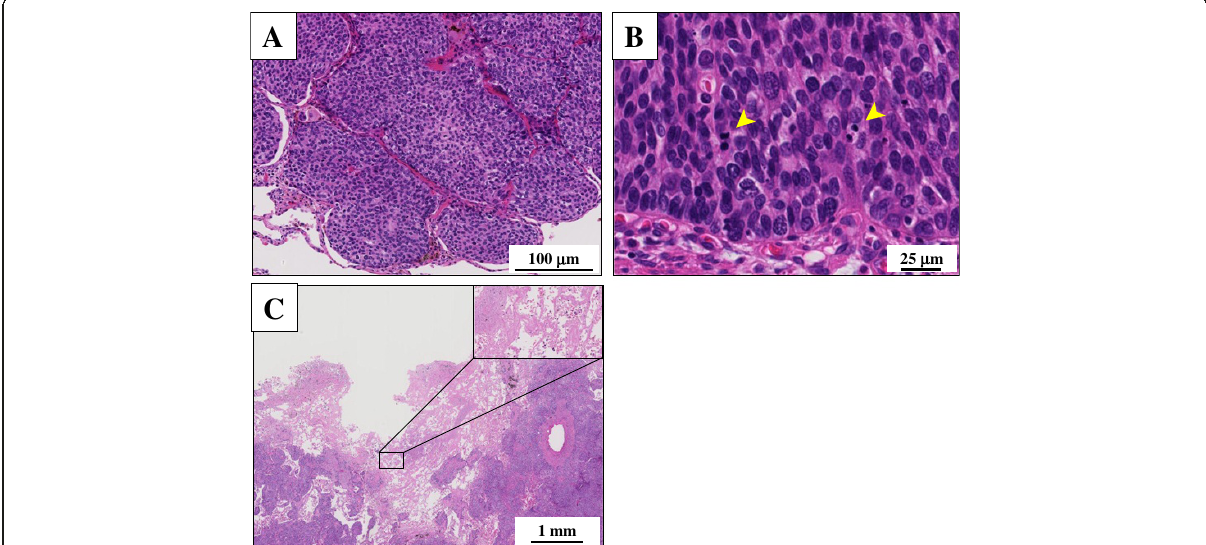
Figure 3 Microscopic examination of the BC of the lung. ( A ) Low power view showed a solid and sheet-like proliferation of relatively uniform and small to medium-sized atypical epithelial cells having hyperchromatic nuclei and scant eosinophilic cytoplasm, often arranged in an alveolar fashion with peripheral palisading. However, rosettes structures were absent. Apparent keratinization, intercellular bridge, or glandular differentiation was also not evident (H&E stains). Bar = 100 μ m. ( B ) On high-power view, mitotic counts (arrowheads) were high (more than 15 per 2 mm 2 ) (H&E stains). Bar = 25 μ m. ( C ) Although foci of comedo-type tumor necrosis were not recognized within the cancer nests and the central cavity, the cancer-cavity junction contained coagulative necrosis of pre-existing alveolar wall (inset) (H&E stains). Bar = 1